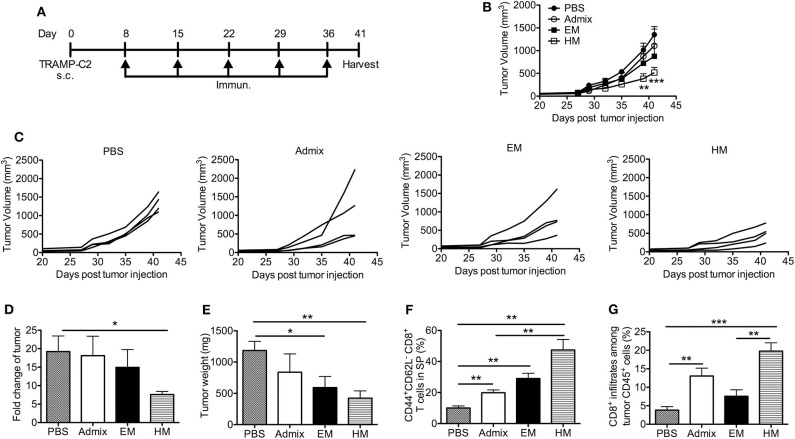
HM IS-SNAs inhibit TRAMP-C2 tumor growth. Mice (4 mice per group) inoculated subcutaneously with TRAMP-C2 tumor cells were immunized with admix, EM or HM IS-SNAs containing PAP and CpG every week for 5 times, tumors and spleens were harvested on day 41. (A) Treatment schedule for TRAMP-C2 tumor bearing mice. (B) Average and (C) individual tumor growth curve of TRAMP-C2 bearing mice. **p < 0.01 (day 39) and ***p < 0.001 (day 41) for  vs ; *p < 0.05 for  vs  (day 41), calculated by two-way ANOVA with bonferroni multiple comparisons post-test. (D) The fold change of tumor was calculated using tumor volume of last measurement (day 41) divided by the 1st tumor measurement (day 27). (E) Tumor weight on day 41. (F) Percentage of CD44+CD62L− CD8+ T cells in spleens on day 41. (G) Percentage of CD8+ T cells among CD45+ cells in tumor. All data are presented as mean ± SEM. *p < 0.05, **p < 0.01, and ***p < 0.001, analyzed by two-tailed unpaired Student's t-test (D–G).